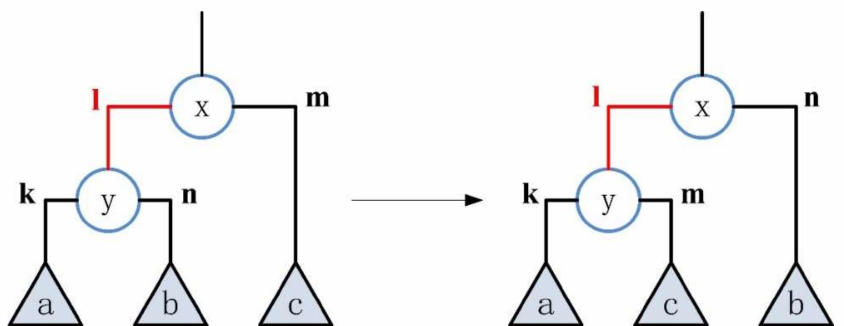
Figure 3. The α transformation of the inner edge of type